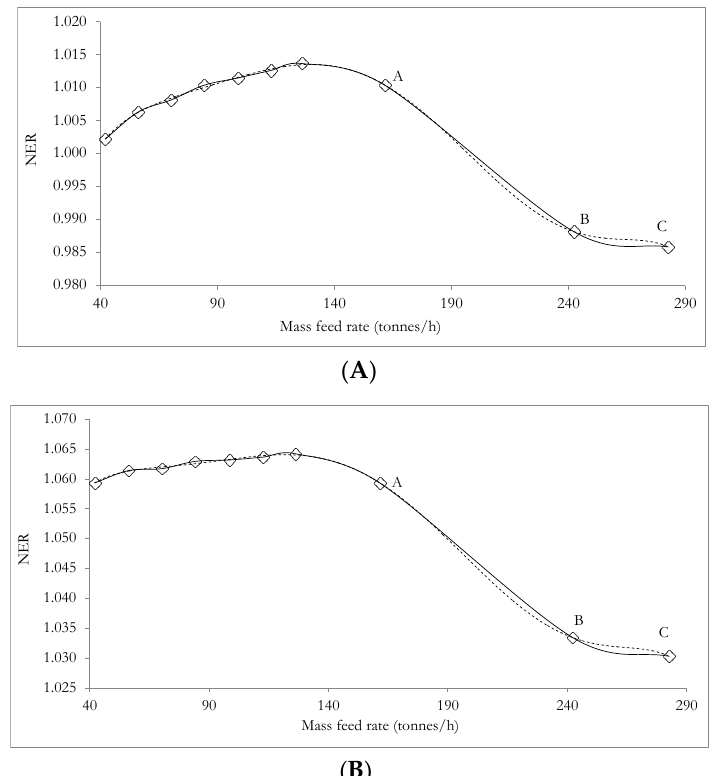
Figure 7. Variation of the NER with the mass feed rates. Points A, B and C represent mass feed rates of TMPS that are 192%, 288% and 336% (all greater than 150%) of the base case TMPS mass feed rate of 84.2 tonnes/h. ( A ): Case A and ( B ): case B.